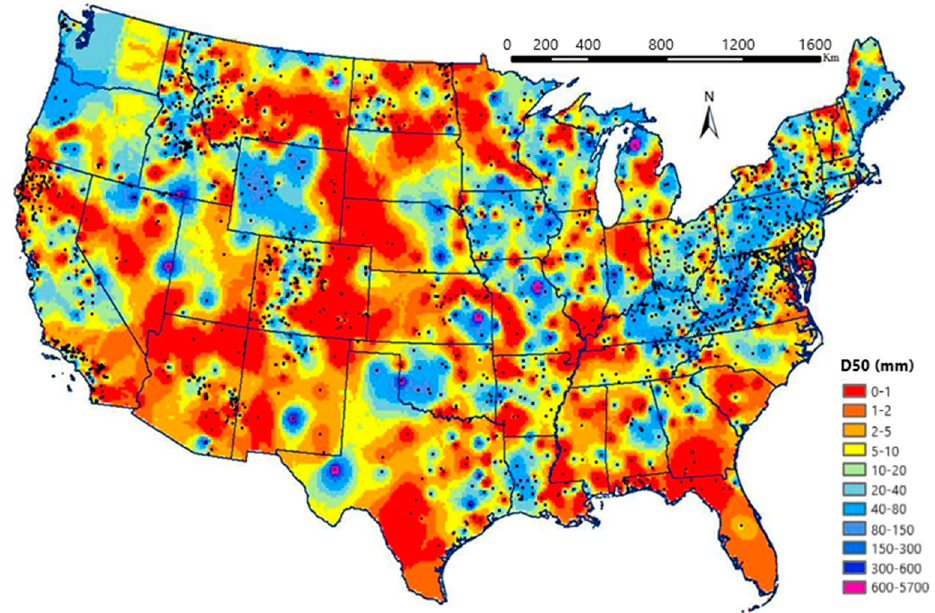
Figure 10. Map of interpolated D50 over the Contiguous U.S. Note: The map was prepared using the log value of more than 2200 D50 data points collected from five sources; black dots on the map show the locations of D50 data points.